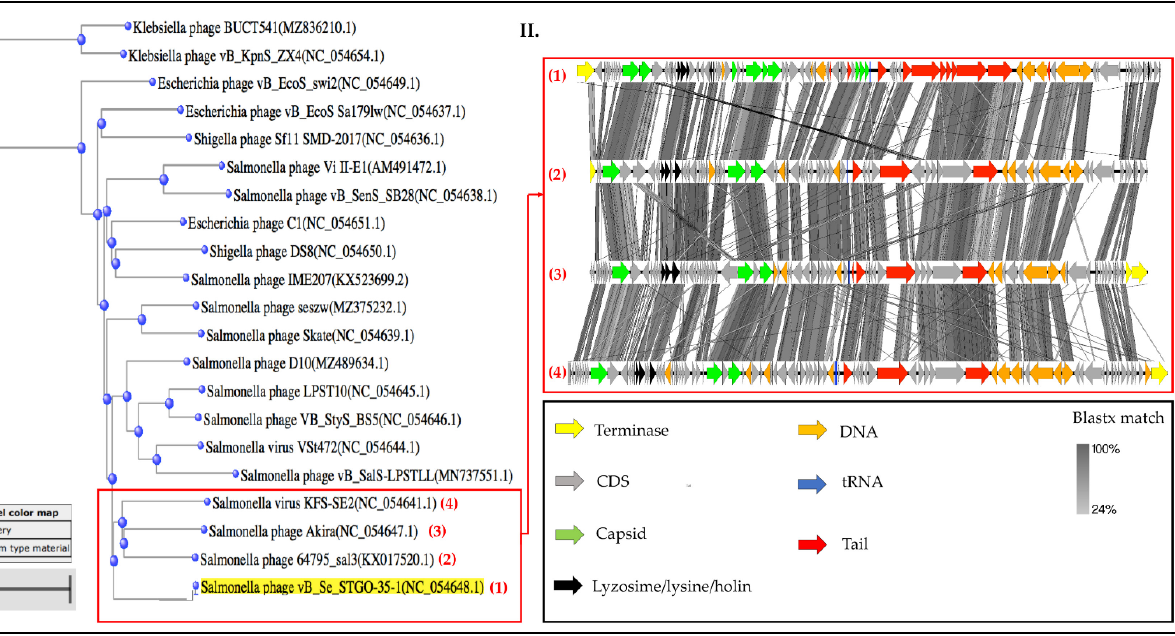
Table 1. Protein homology detection and structure prediction of STGO-35-1.